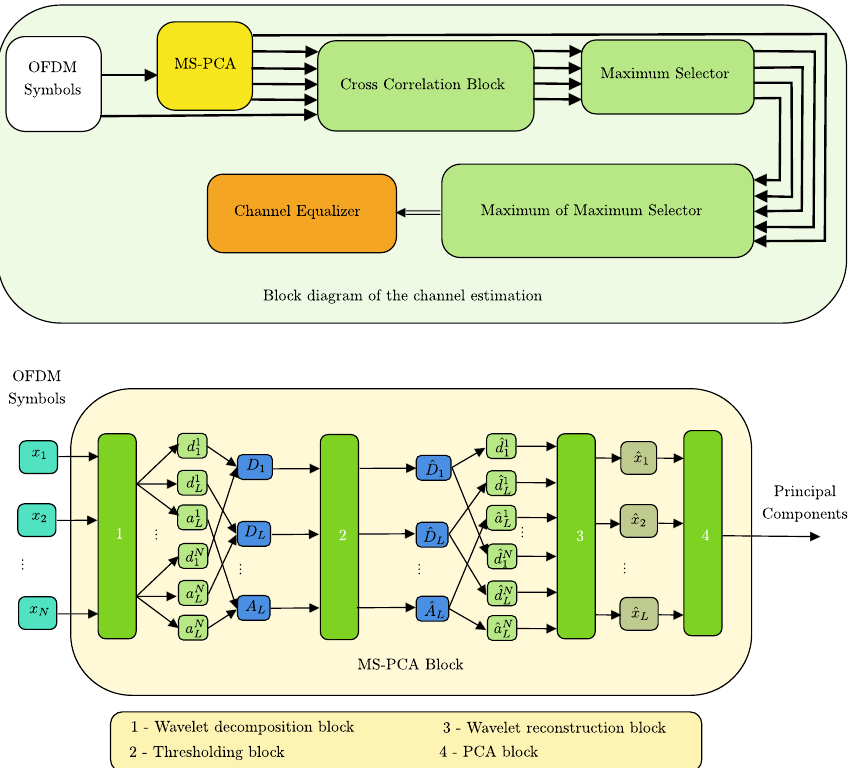
Fig. 8 Channel estimation using the I-MSPCA proposed in